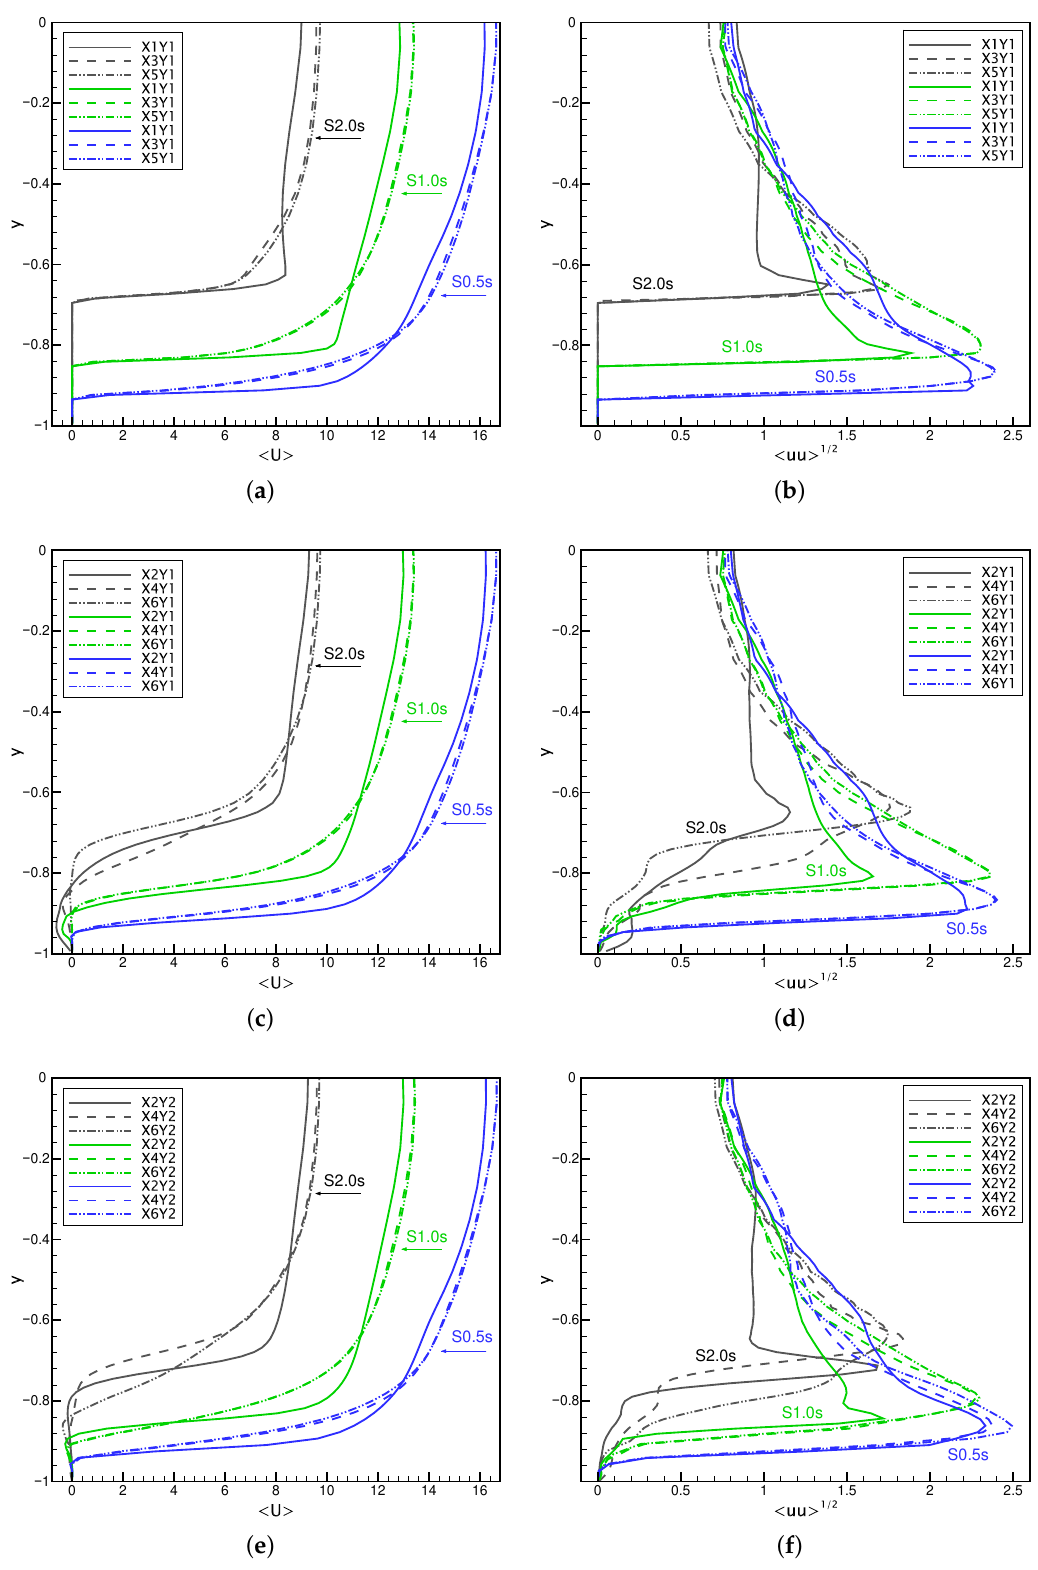
Figure 10. Profiles of the time-averaged streamwise velocity ( a , c , e ) and its fluctuations ( b , d , f ) along the channel height at the selected control points X and Y defined in Figure 3b. The results for the configurations S0.5s, S1.0s, and